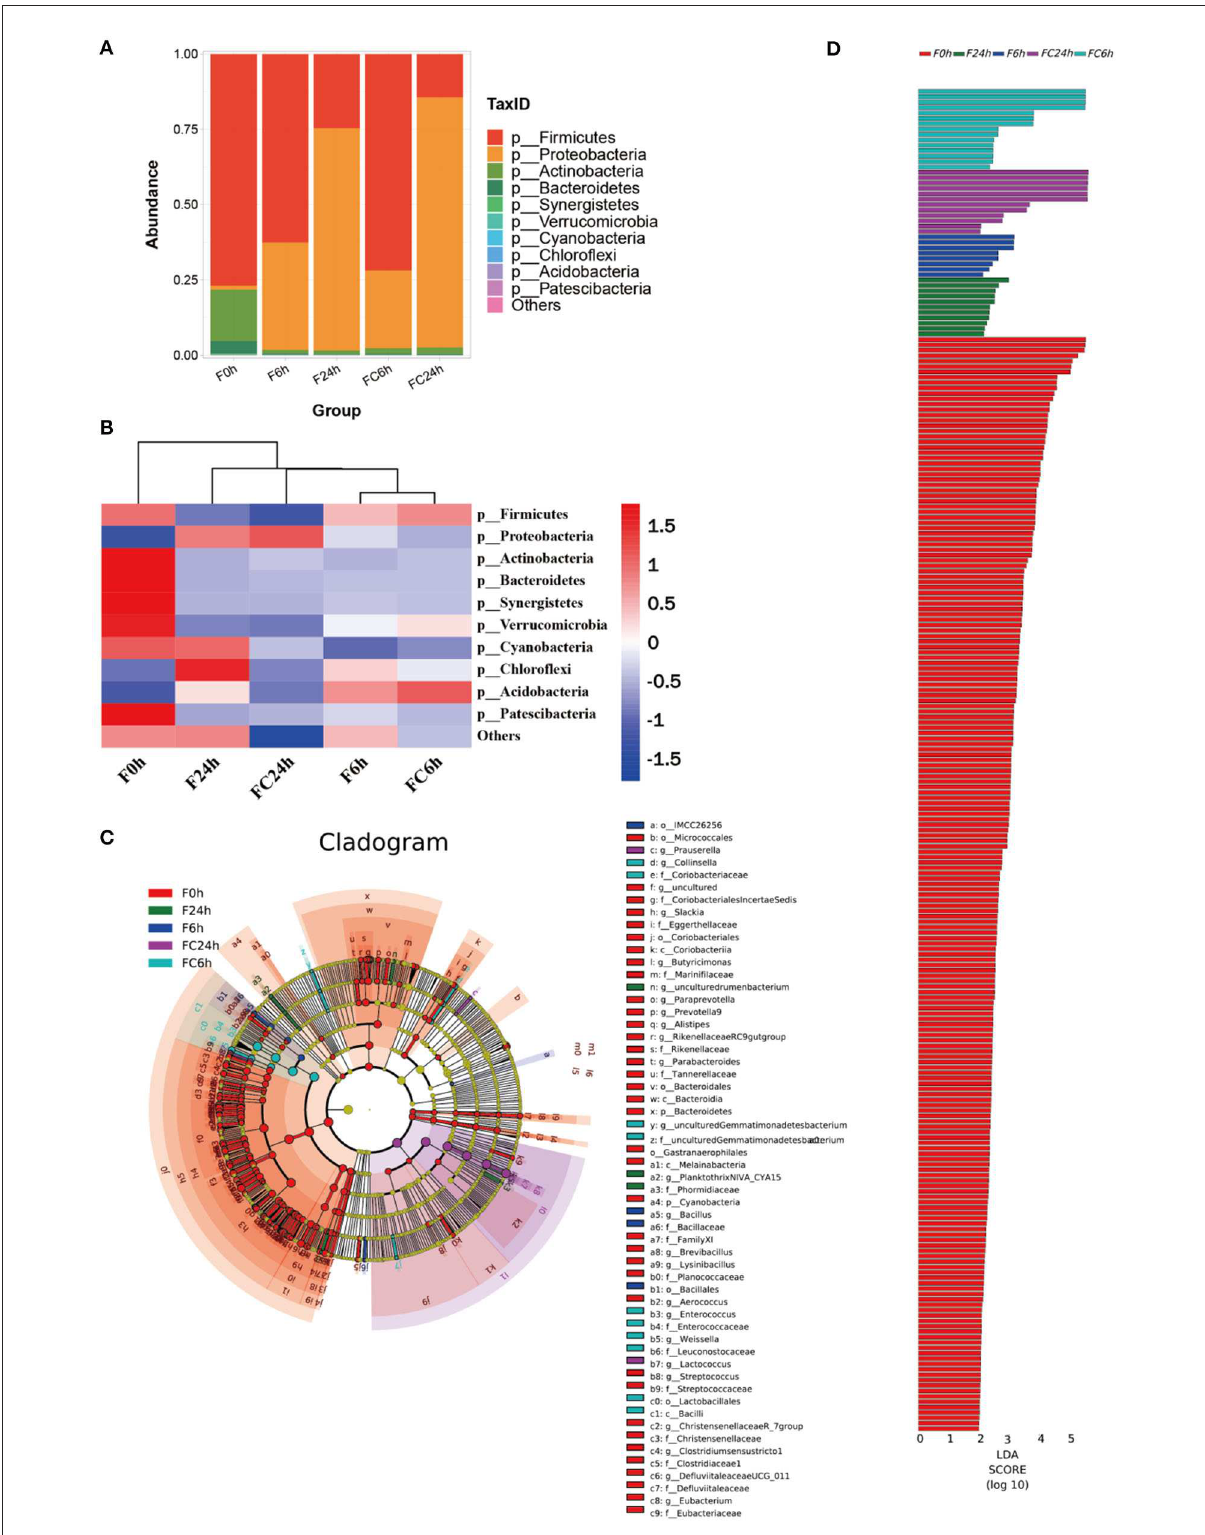
FIGURE9 Effects of FJR on the structure of the gut microbiota composition in vitro fecal fermented at different times. (A) Microbial composition at phylum level during in vitro fecal fermentation; (B) The heatmap of the gut microbiota in all groups at the phylum level; Histogram (C) and cladogram (D) from LEfSe analysis. F0h = Fermentation for 0h with FJR; F6h = Fermentation for 6h with FJR; F24h = Fermentation for 24h with FJR; FC6h = Fermentation for 6h without FJR; FC24h = Fermentation for 24h without